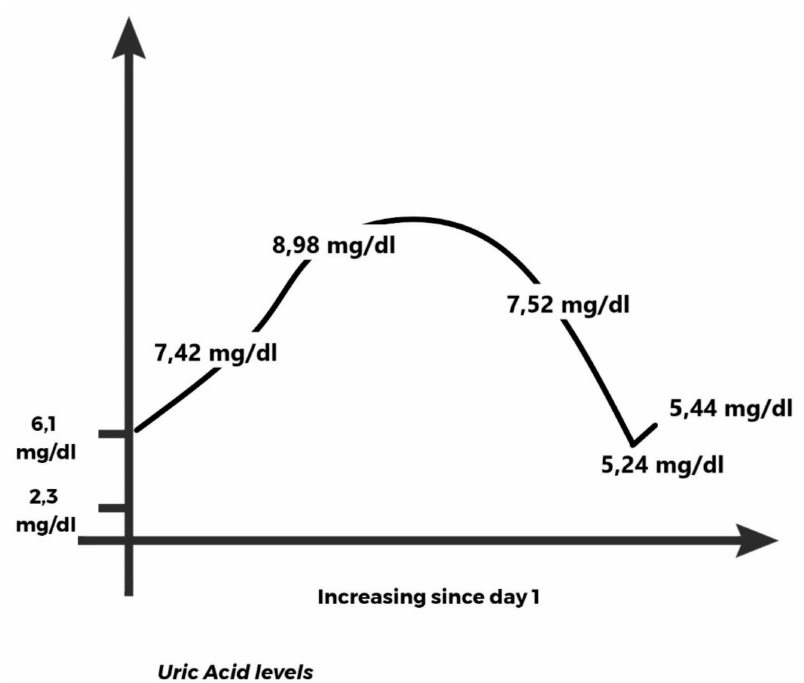
Figure 1. Changes in the uric acid levels.